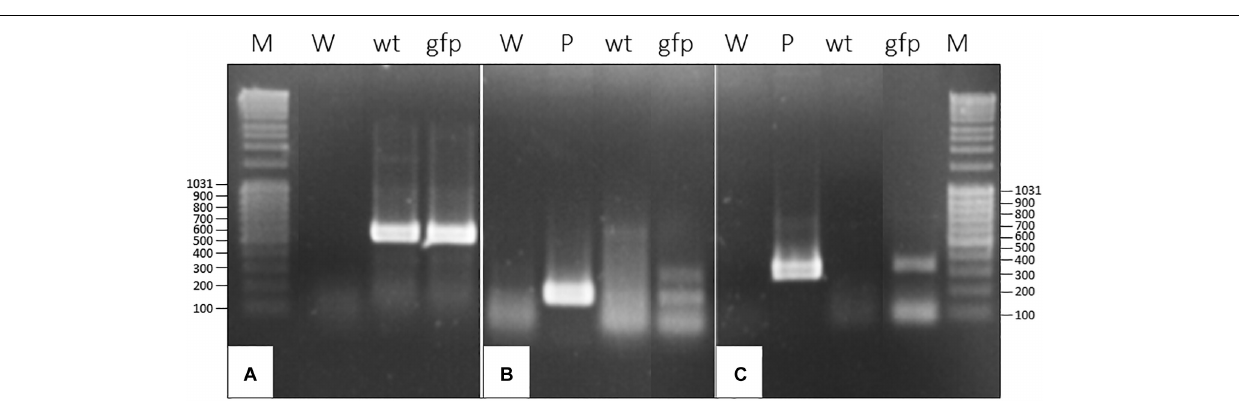
FIGURE 2 | RT-PCR on RNA extracted of gfp -transformed D. capensis plant coming from T1 generation produced by chimeric transgenic plant. (A) RT-PCR with primers specific to 18S ribosomal RNA gene as housekeeping gene (467 bp); (B) RT-PCR with primers specific to nptII (199 bp); (C) RT-PCR with primers specific to gfp (329 bp); M, Marker; W, water; wt, RNA from wild-type plant; P, plasmid; gfp, RNA from non-chimeric gfp